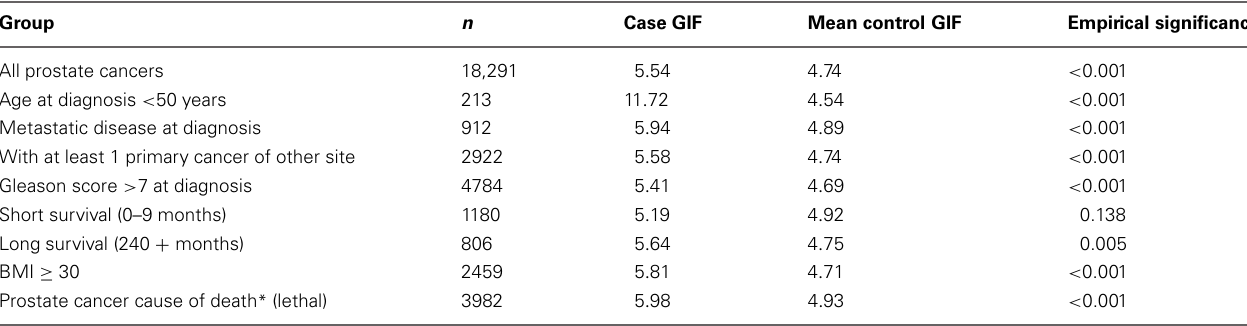
Table 2 | GIF analysis of prostate cancer relatedness compared to expected relatedness in the UPDB population. Group n